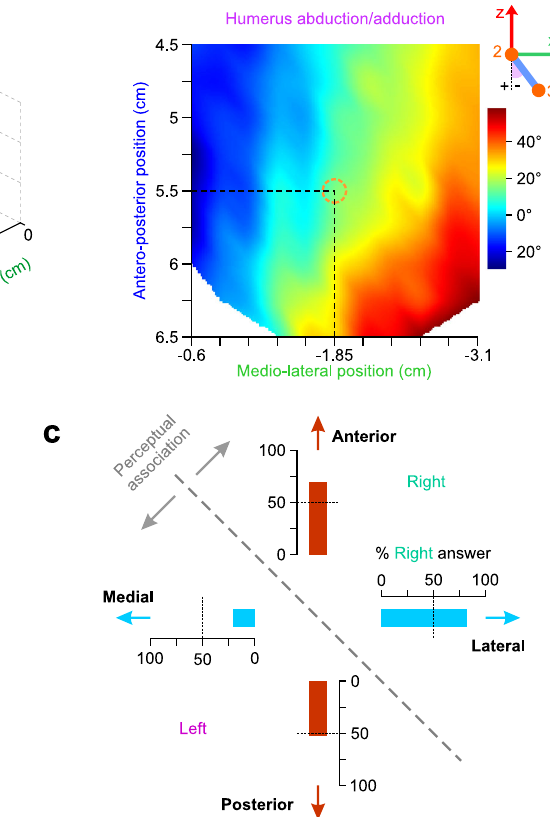
(positive values) as the limb is displaced by 4mm in the medial, lateral, posterior and anterior directions. c % right answer means ( N =4 mice) of the data in Fig. 3H for the trained (medial and lateral) and probe (anterior and posterior) directions. Theperceptualassociationaxisisorthogonaltothejointsimilarityaxisinb.Source data are provided as a Source Data fi